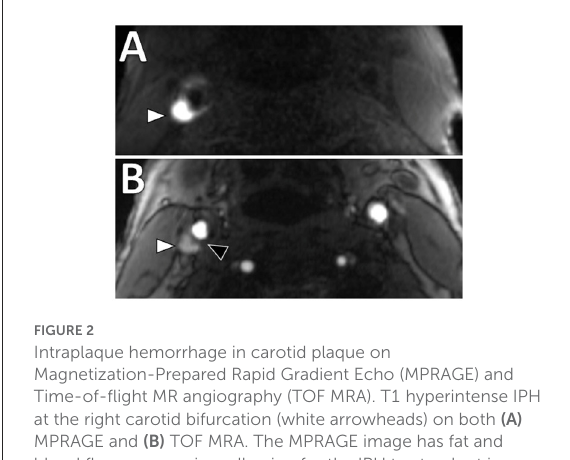
FIGURE2 Intraplaque hemorrhage in carotid plaque on Magnetization-Prepared Rapid Gradient Echo (MPRAGE) and Time-of-flight MR angiography (TOF MRA). T1 hyperintense IPH at the right carotid bifurcation (white arrowheads) on both (A) MPRAGE and (B) TOF MRA. The MPRAGE image has fat and blood flow suppression, allowing for the IPH to standout in contrast to the vessel lumen and surrounding soft tissues. The TOF MRA image also demonstrates an intact hypointense fibrous cap at this level (black arrowhead).